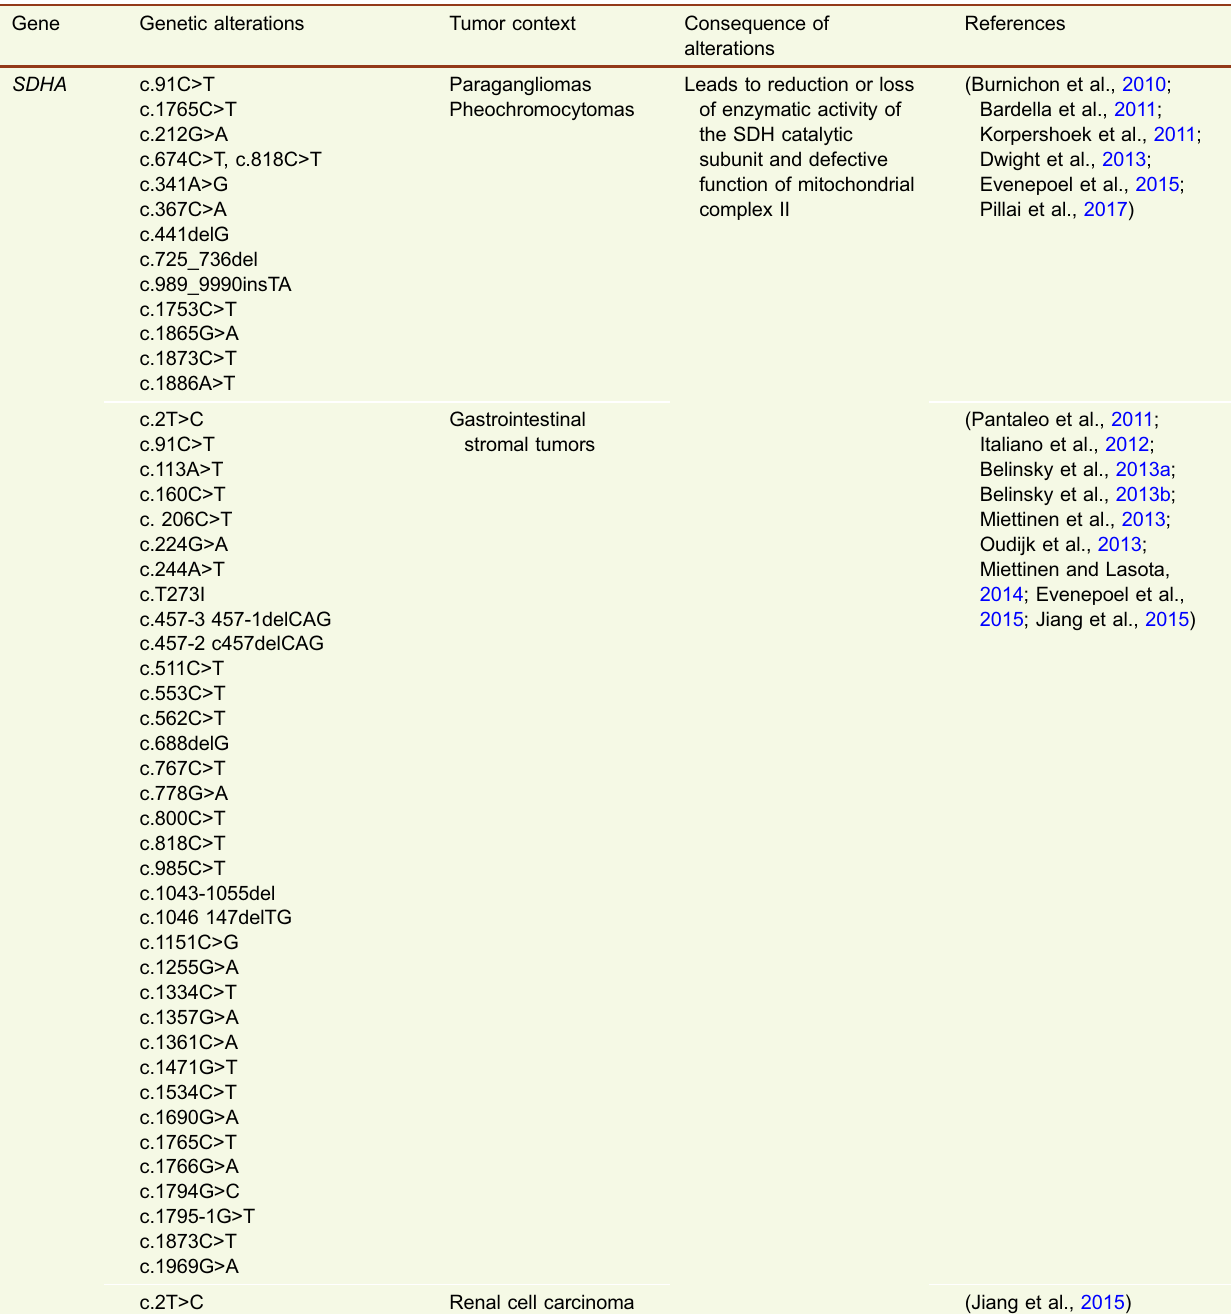
Table 1. Summary of cycle enzyme genetic alterations in